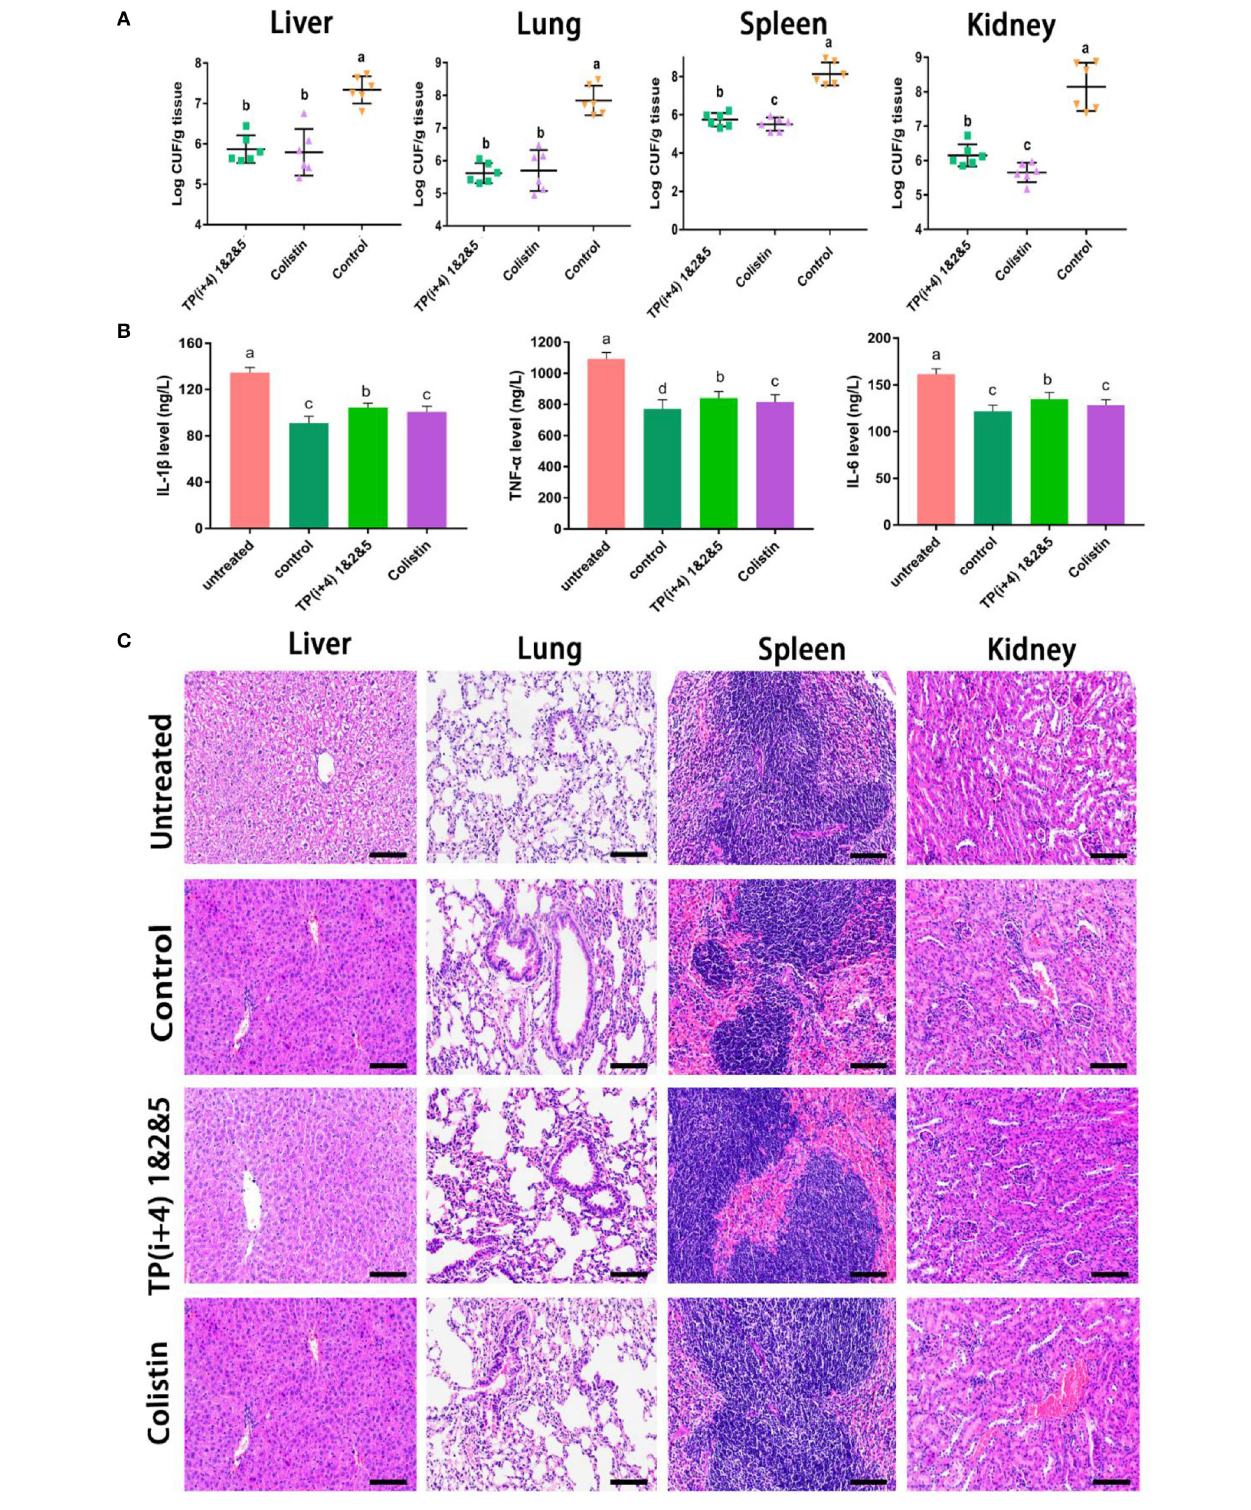
FIGURE 6 | In vivo therapeutic evaluation of the target peptide TP(i + 4) 1&2&5 in a mouse model of bacterial peritonitis (A) Bacterial load in different organs ( n = 6) (B) Regulation of peptides on serum cytokine (IL-6, IL-1 β , and TNF- α ) levels (C) Peritonitis C57BL/6 mice liver, spleen, kidney, lung tissue pathological morphology observation. Scale bar: 100 µ m. (A,B) Values with different superscripts (a, b, c, d) indicate a significant difference ( p < 0.05).